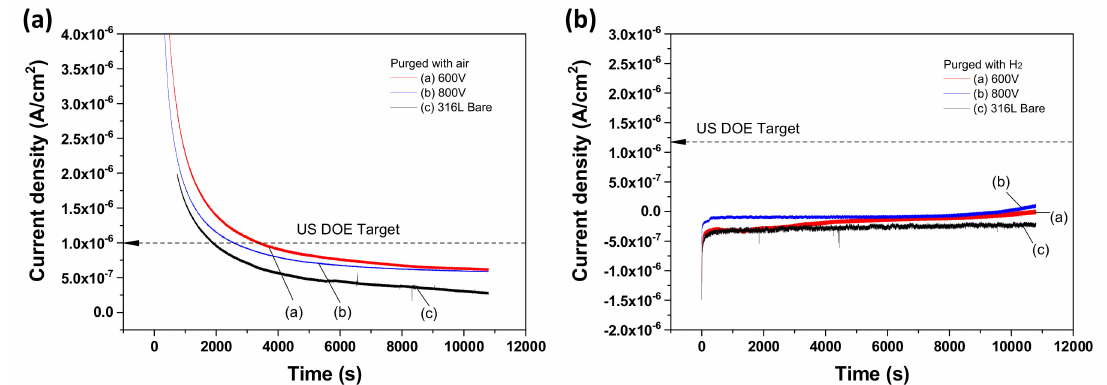
Figure 2. Potentiostatic polarization curves of Nb-coated 316L samples in 0.5 M H 2 SO 4 at 70 °C ( a ) at 0.6 V with purged air and ( b ) at − 0.1 V with purged H 2